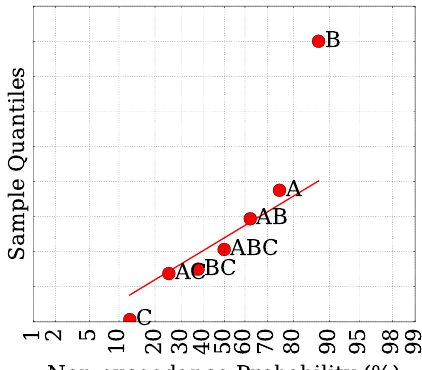
Figure 9: Coating thickness contrasts